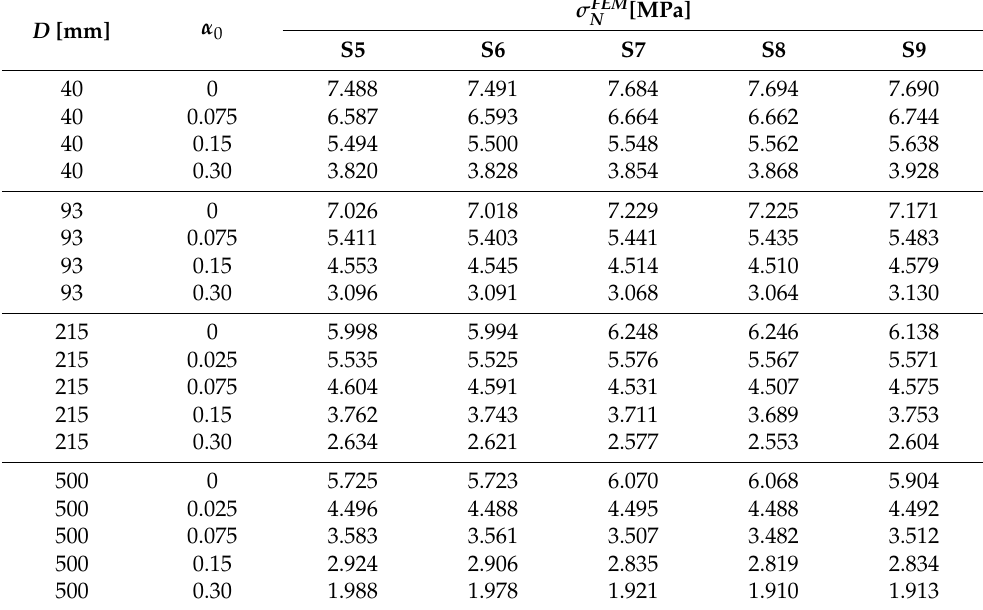
for bilinear softening curves and sets N